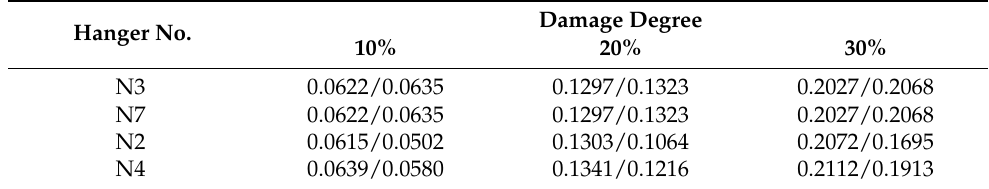
Table 3. Actual cable force reduction ratio and identification results (two hangers damaged simulta-